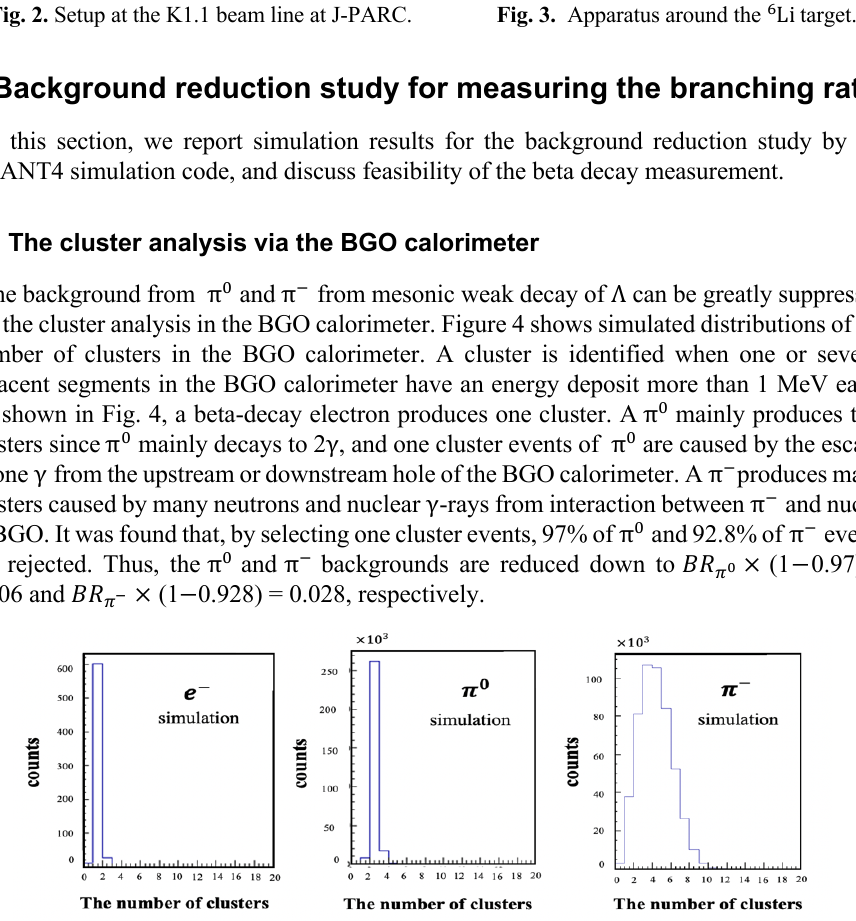
Fig. 2. Setup at the K1.1 beam line at J-PARC. Fig. 3. Apparatus around the Li % target.